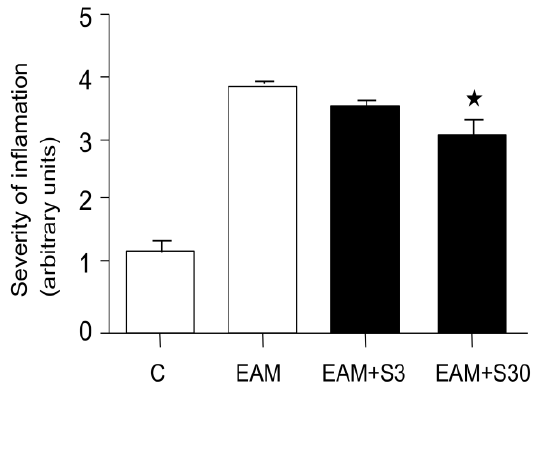
Figure 6. Effect of simvastatin on severity of inflammation. C indicates not immunized group without simvastatin, EAM — group with induced EAM without simvastatin; EAM+S3 — low- dosage simvastatin EAM group (3 mg/kg/d); EAM+ S30 — high-dosage simvastatin EAM group (30 mg/kg/d).